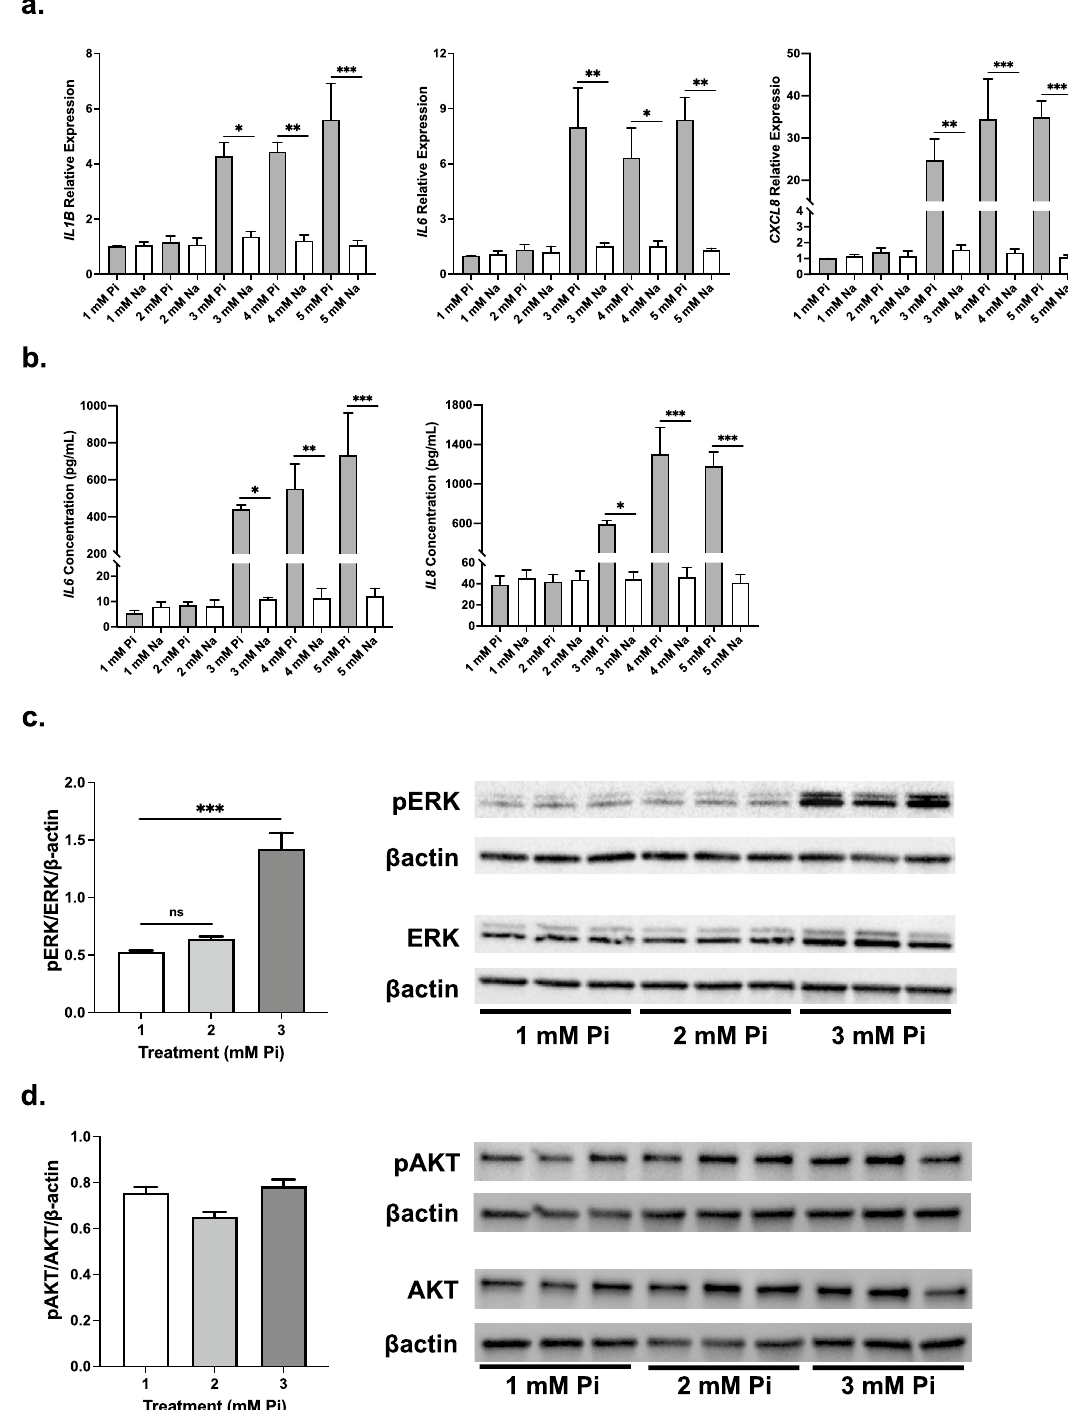
Figure 4. Phosphate induces inflammatory cytokine expression, secretion, and ERK activation in HBECs. ( a ) Relative mRNA transcript levels of IL1B , IL6 , and IL8 in BEAS-2B HBECs after 24 h sodium phosphate (Pi) or sodium sulfate (Na) treatment. ( b ) IL6 and IL8 protein levels in conditioned media. ( c ) Representative immunoblots and quantification of ERK phosphorylation in total protein extracts from BEAS-2B HBECs. βactin serves as loading control. ( d ) Representative immunoblots and quantification of AKT phosphorylation in total protein extracts from BEAS-2B HBECs. βactin serves as loading control. All experiments were reproduced 3 times with triplicates. All values are mean ± SEM with *p ≤ 0.05, **p < 0.01, and ***p < 0.001. Original western blots presented are available in Supplemental Fig. S1. Statistical significance was analyzed via two-way ( a , b ) or one-way ( c , d ) ANOVA followed by Tukey’s multiple comparison post hoc